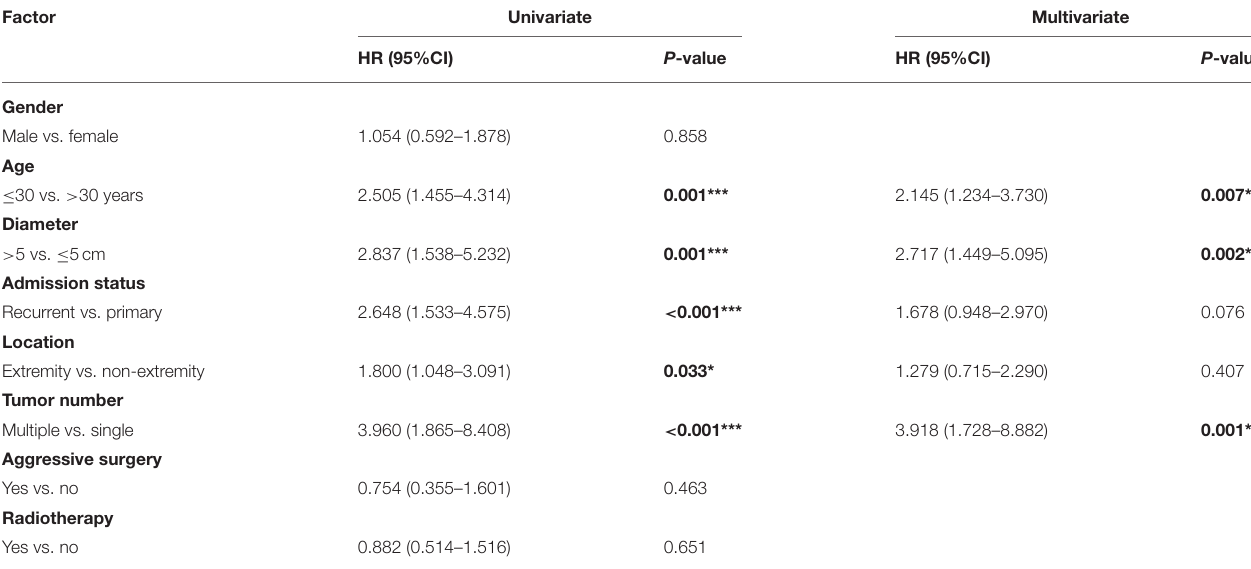
TABLE 2 | Univariate and multivariate Cox analysis of risk factors associated with recurrence.